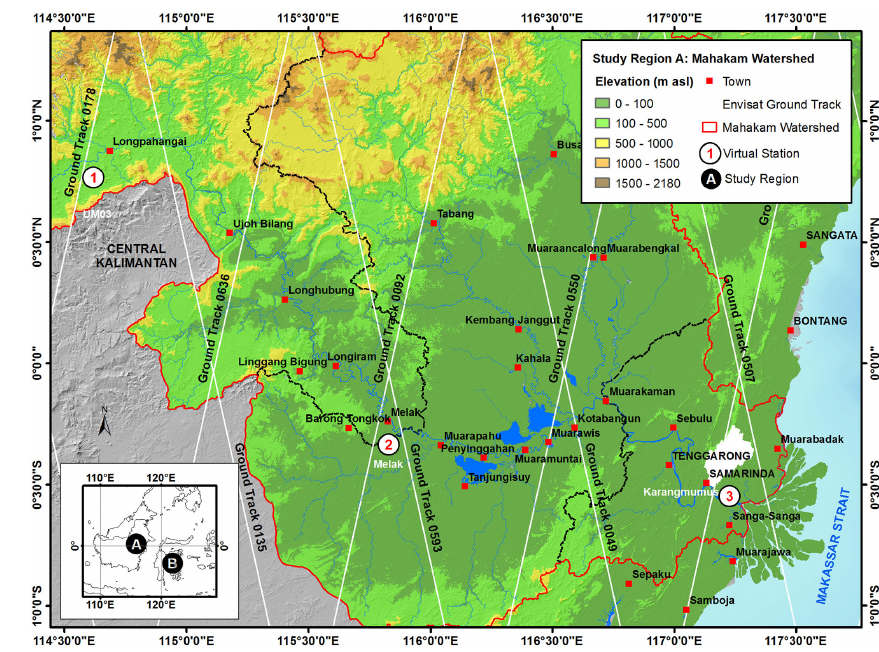
Figure 1. Study sites at the Mahakam watershed, East Kalimantan,